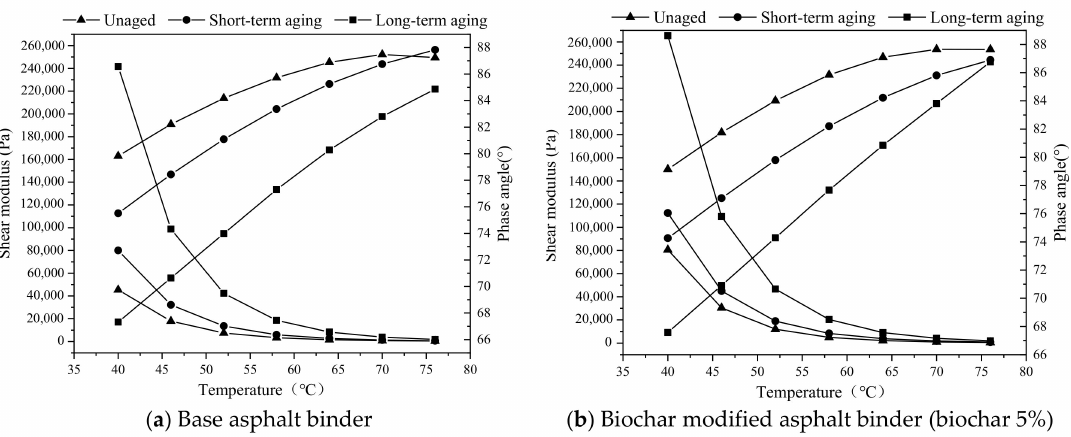
Figure 3. E ff ect of ageing on the rheological behavior of asphalt